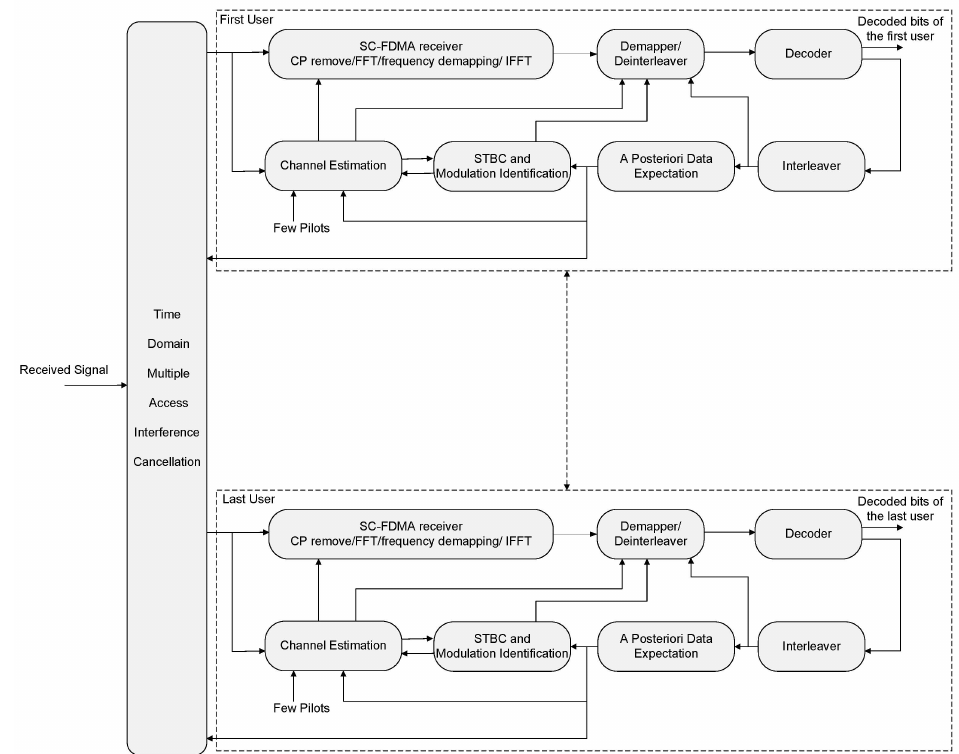
Figure 2. The proposed structure of the